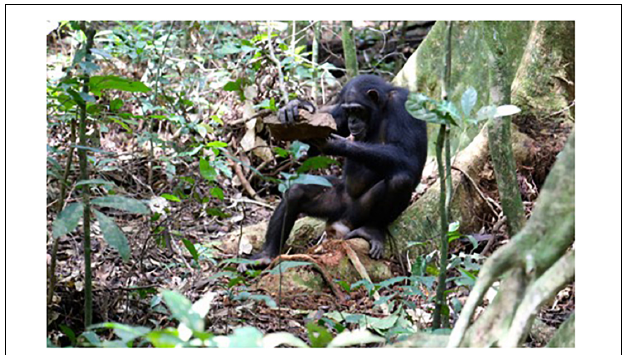
FIGURE 2 | Chimpanzee pounding a nut with a stone hammer. Photo by Liran Samuni as part of the Tai Chimpanzee Project.